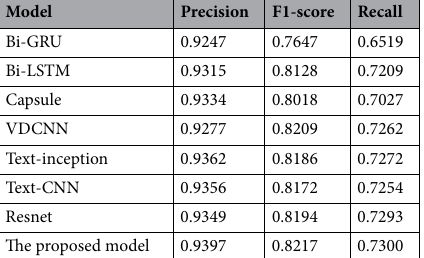
Table 3. Comparison results with other models on the CAIL2018 dataset.